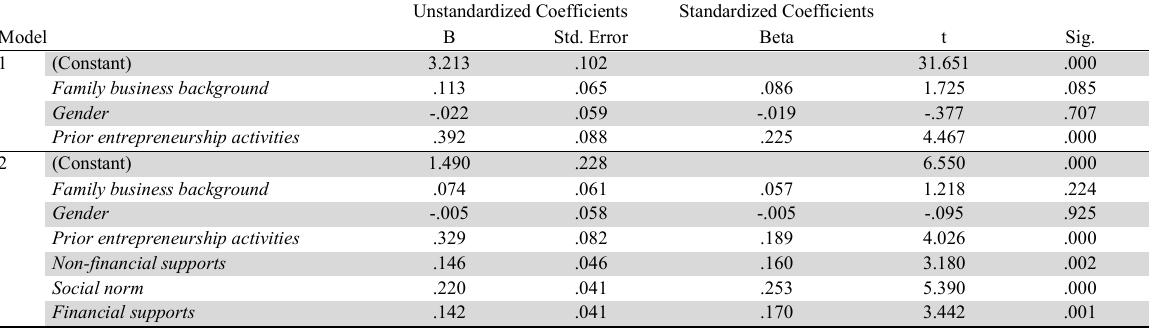
The results of regression analysis